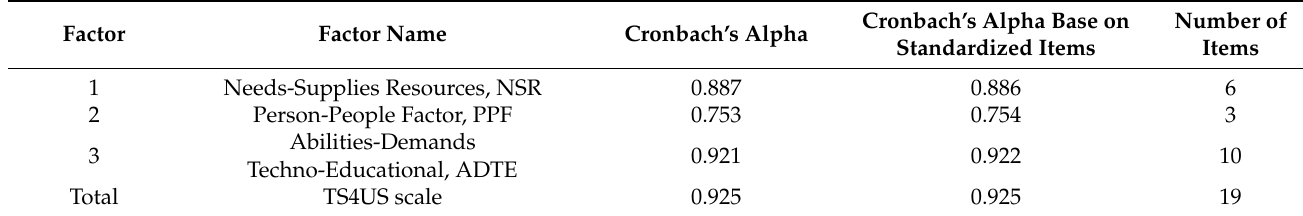
Table 9. Reliability